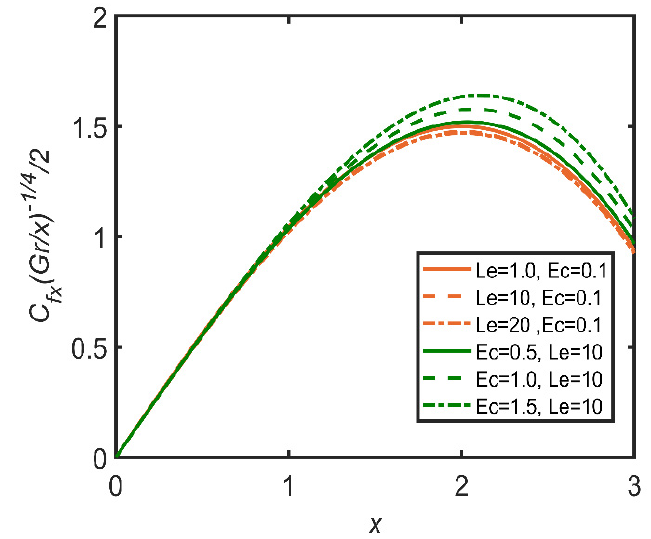
Figure 24. Comparison for skin friction against x.